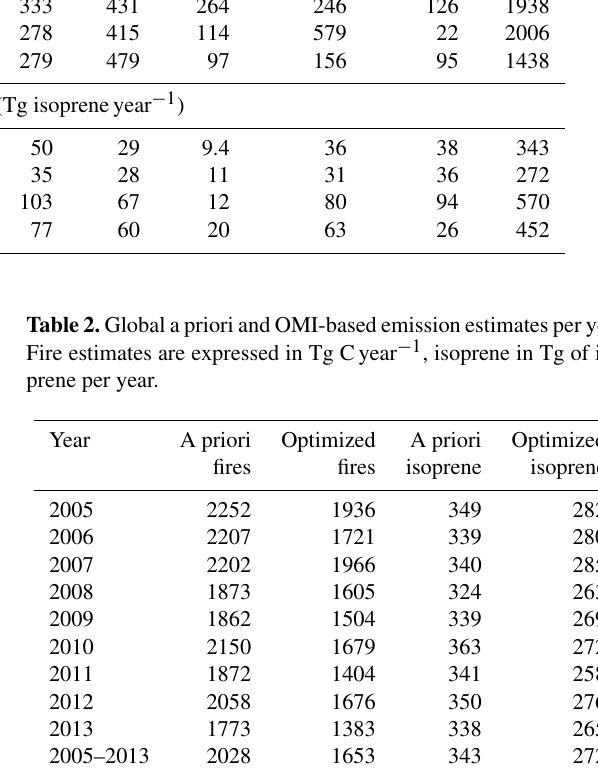
(Fig. S3). MEGAN-MACC (Sindelarova et al., 2014) re- lies on the MEGANv2.1 model for biogenic volatile